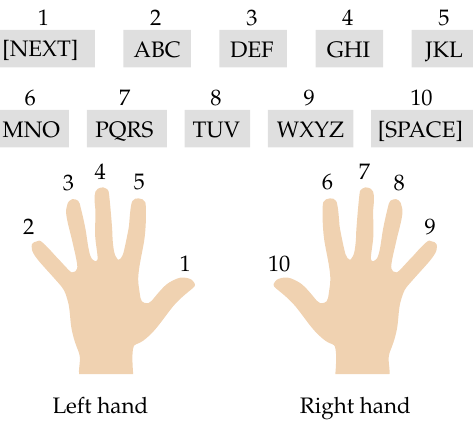
Figure 2. Ambiguous keyboard layout based on the SAK approach by MacKenzie et al. [5]. The input of letters is compared with a built-in dictionary and generates a word suggestion list. The Space key is used to choose the currently selected word. Perspectively, the suggestion list can be browsed by using the Next key. If the desired word is not listed, it can be inserted using the mouse alternative and an on-screen keyboard.